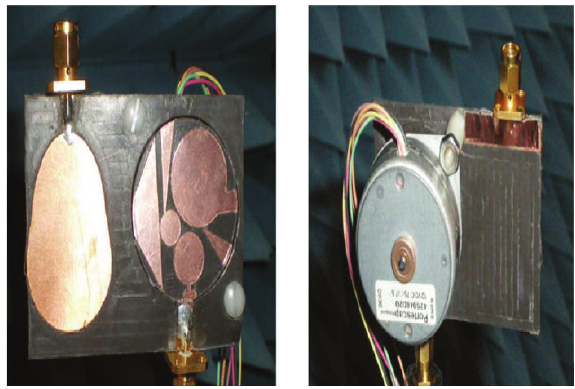
Figure 4: Implemented front-end using rotatable controlled recon- figurable antennas